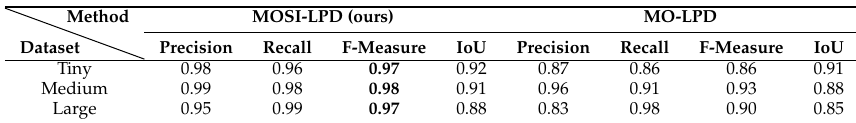
Table 3. Performance comparison between our MOSI-LPD and MO-LPD on the “Tiny”, “Medium” and “Large” test subsets.